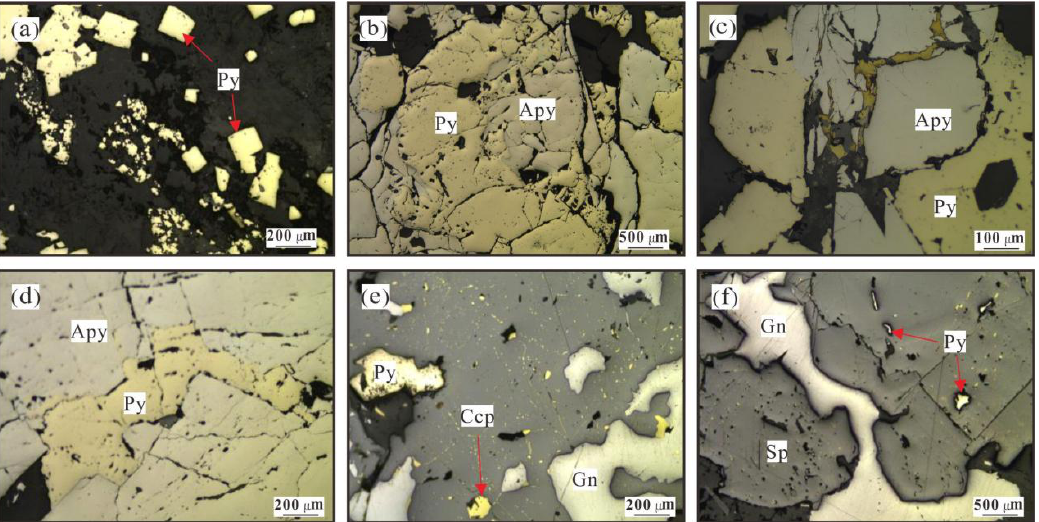
Figure 2. Photomicrographs of mineral assemblages, showing mineralogical characteristics of the ore samples from the Jilinbaolige deposit. ( a ) Cubic pyrite, ( b , c ) dissolution and metasomatism by arsenopyrite pyrite, ( d ) late pyrite filling the early arsenopyrite fissures, ( e ) galena replacing other sulfide minerals, and ( f ) galena filling along sphalerite fissures surrounding pyrite residues. Apy, arsenopyrite; Ccp, chalcopyrite; Gn, galena; Py, pyrite; Sp, sphalerite.